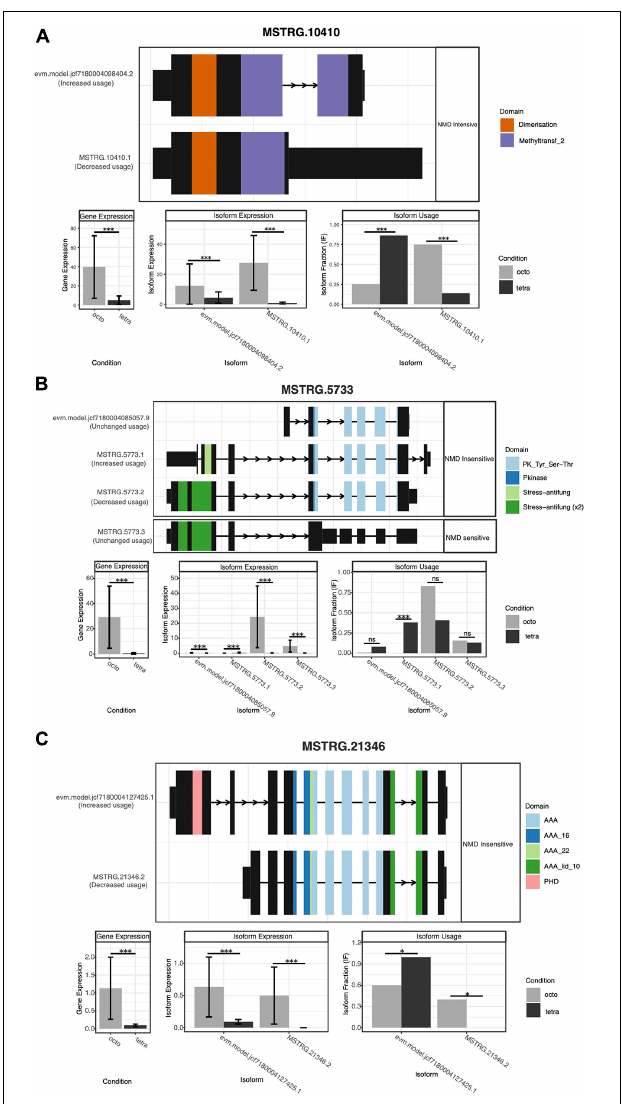
FIGURE 4 | Structural and expression analysis of gene MSTRG.10410 (A) , MSTRG.5733 (B) and MSTRG.21346 (C) for which with alternative splicing events has biological consequences. Isoforms insensitive and sensitive to Nonsense Mediated RNA Decay (NMD). * p -value < 0.05, *** p -value < 0.001, ns, no significant difference. For each gene, the top graph displays gene structure of the isoform, with domains annotated from Pfam database indicated. The bar graph on the left showed the differential gene expression, and the bar graph in the middle indicated the differential isoform expression, and the bar graph on the right represented isoform usage bias between octoploids and